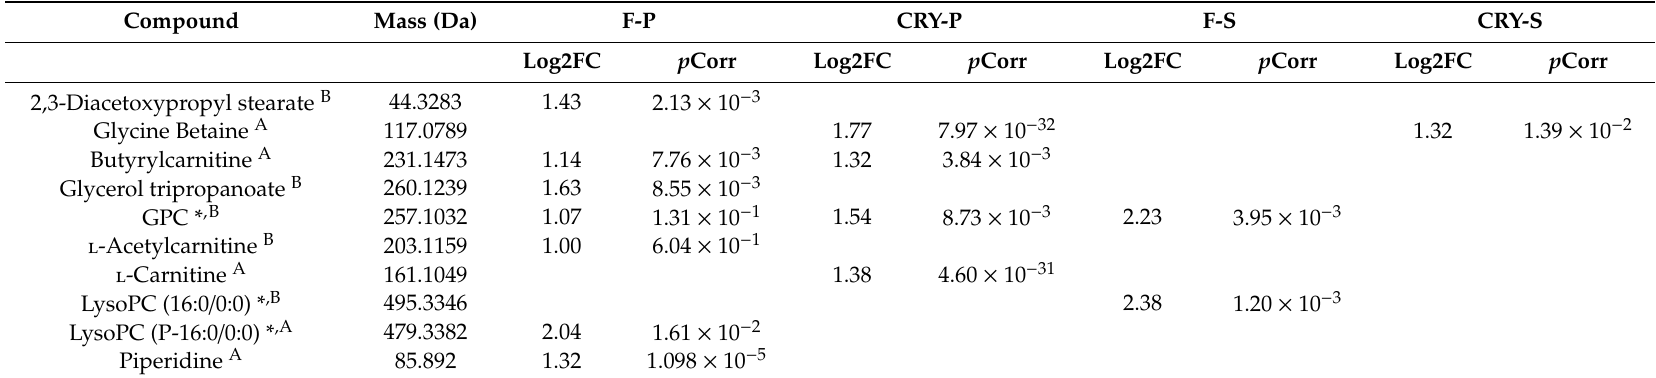
Table 3. Values of p Corrected and Log2Fold Change of putatively identified metabolites in fresh and cryopreserved seminal plasma (F-P, CRY-P) and spermatozoa (F-S, CRY-S) samples in low and high fertility bulls ( t -test with p -value < 0.05 and fold change > 2.0).